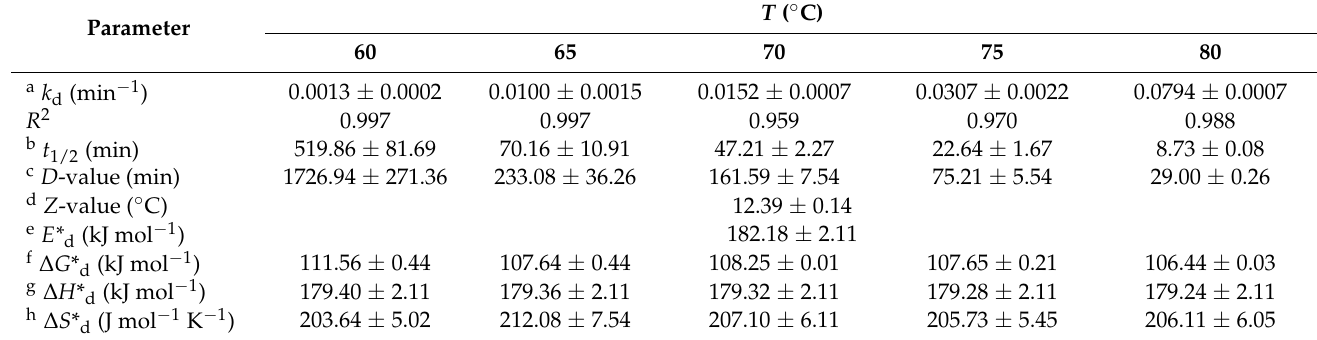
Table 8. Kinetic and thermodynamic parameters of the thermal denaturation of inulinase produced by Aspergillus terreus URM4658 in solid-state fermentation using wheat bran as a substrate.